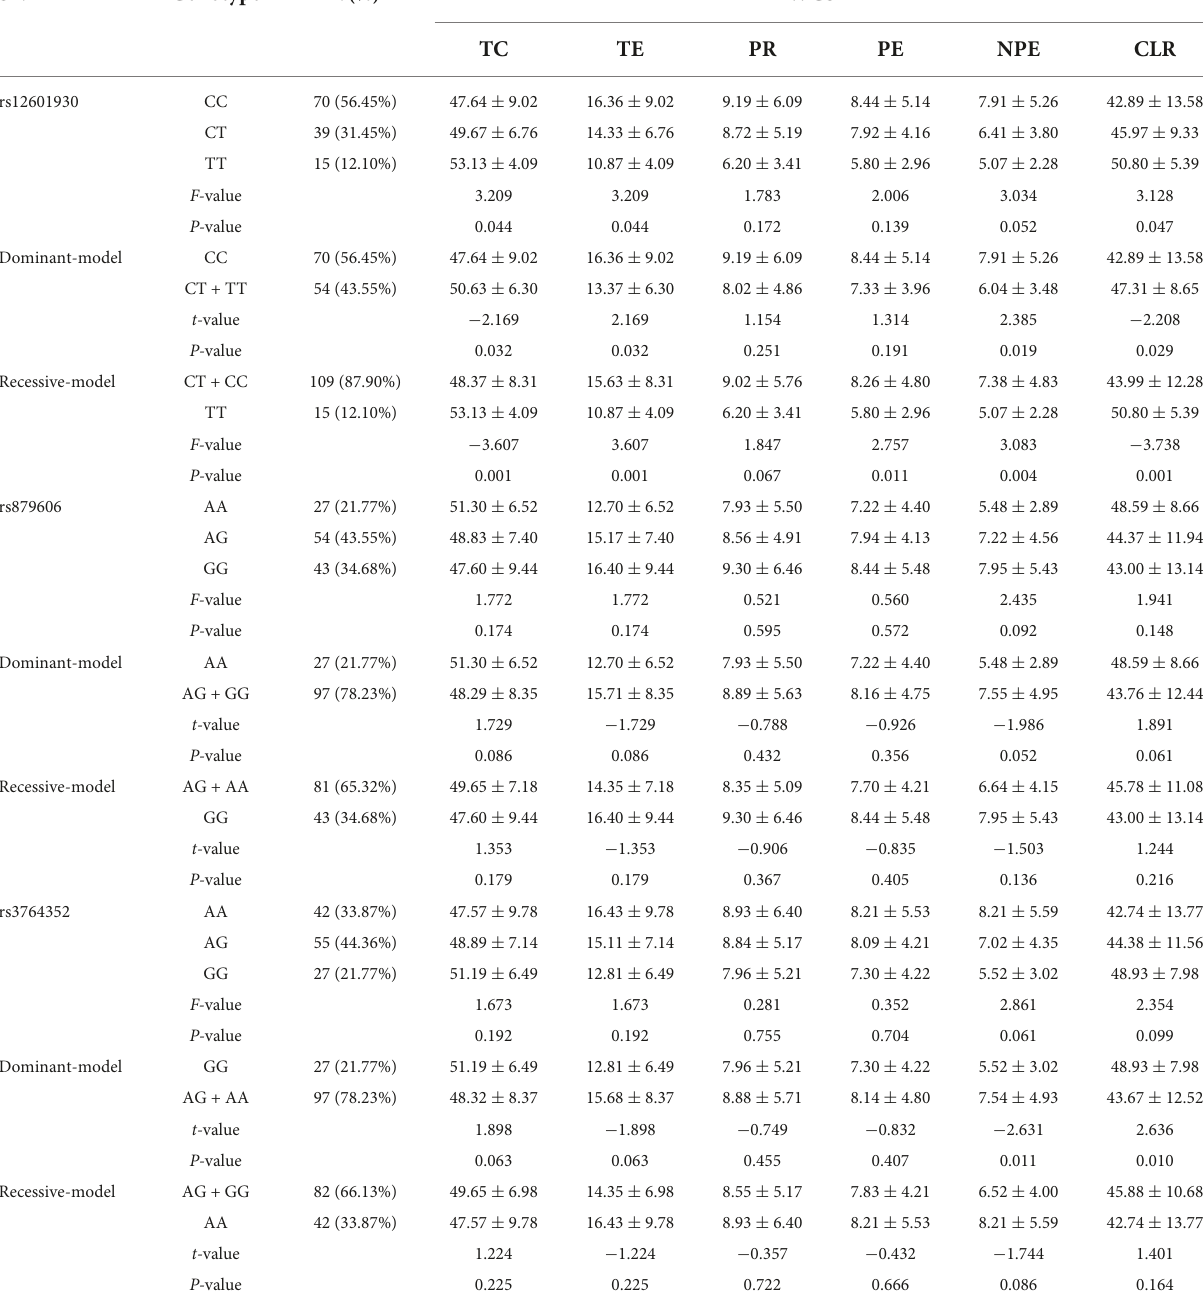
TABLE 1 Effects of PPP1R1B polymorphisms on WCST